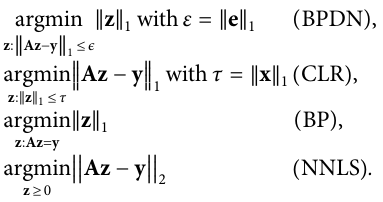
Frontiers in Applied Mathematics and Statistics |